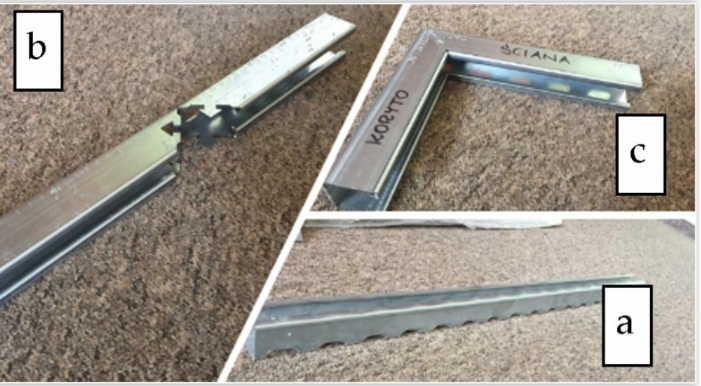
Figure 4. The profile section obtained on the roll-forming line ( a ); a profile section after a laser cutting of a zipper/lock ( b ); and a console with a lock after assembling ( c ). Standard profile of 40 × 40 mm cross-section dimensions.